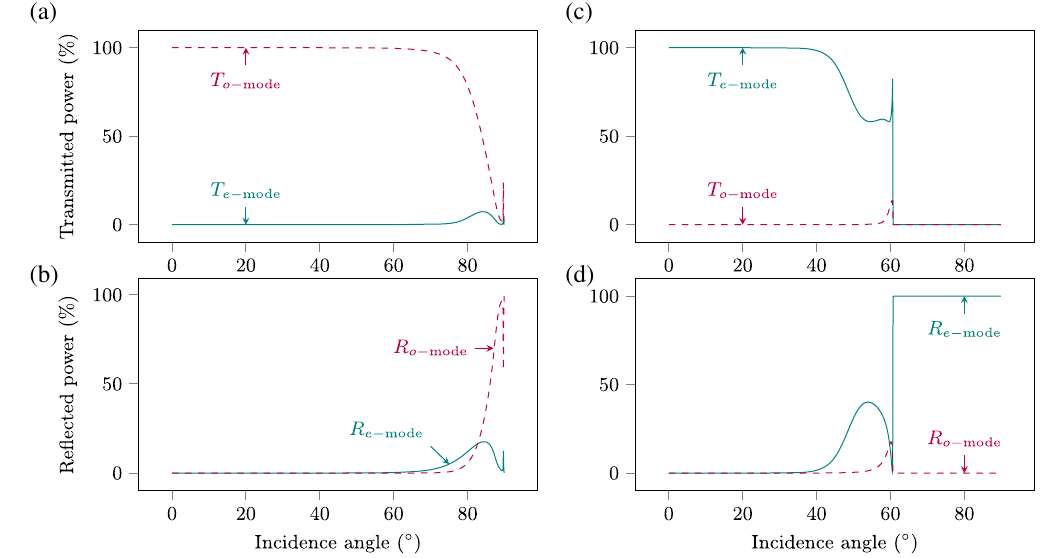
FIG. 11. Transmitted (a) and reflected (b) powers from the midplane permittivity profile of a CF3, assuming an incident ordinary mode. (c),(d) Same as (a),(b) with an incident extraordinary mode. We use the same convention as Fig. 5 for the notation T